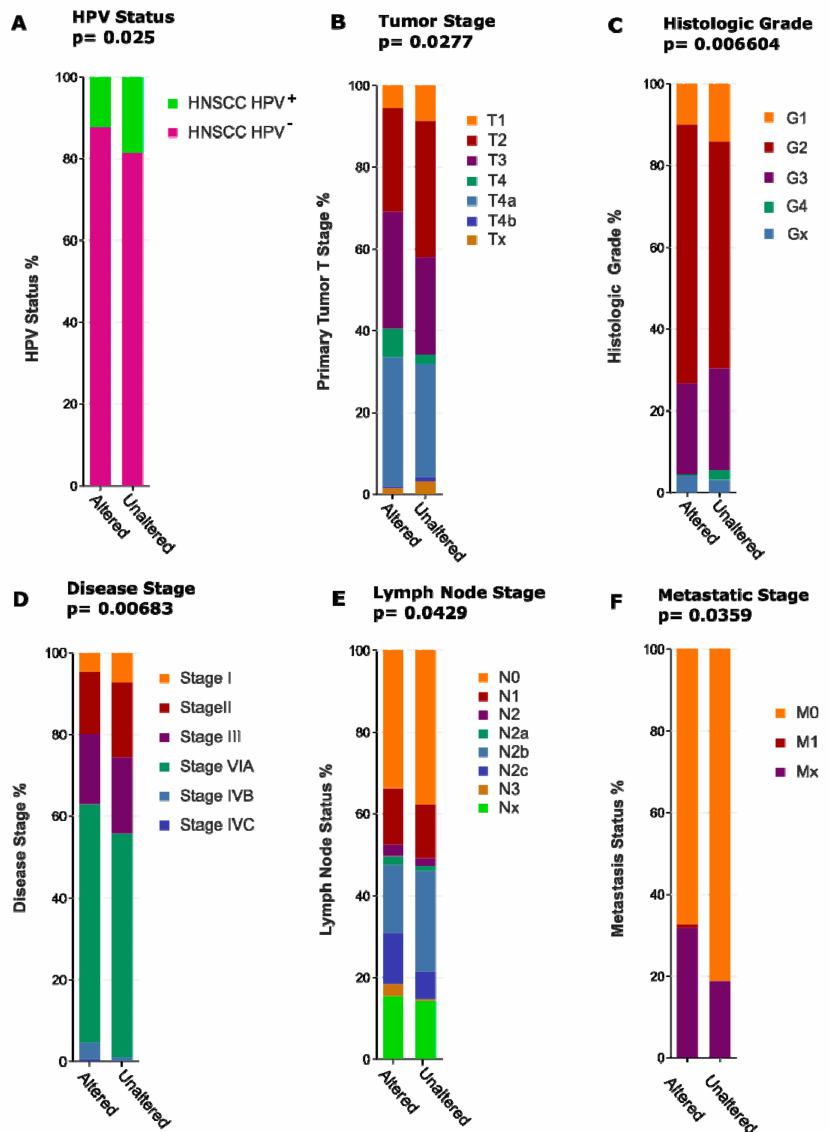
Figure 4. Mutation status of most relevant Notch-pathway related genes incl. NOTCH receptors correlates with various clinical and pathological parameters in HNSCC patients and tissues. Tumours with mutations in prominent Notch pathway-related genes (“altered group”) are less frequently HPV + ( A ). Patients with Notch-pathway alterations present with significantly advanced tumour stage ( B ), histologic grade ( C ), and disease stage ( D ). These patients also more frequently develop lymph node metastases ( E ) and distant metastases ( F